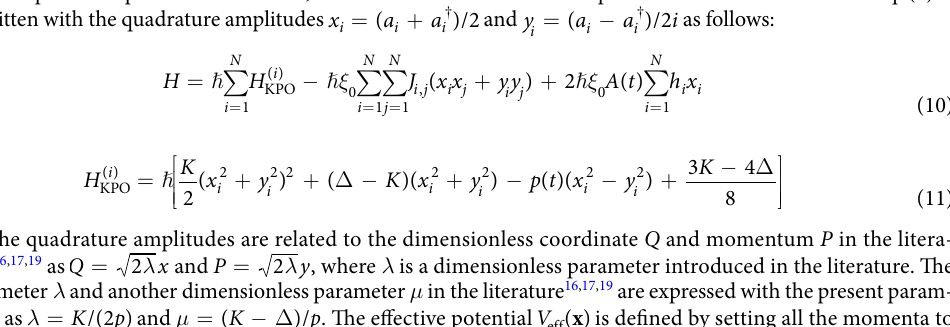
Figure 3. Simulation results of 1000 instances of the two-spin Ising problem. { } J from the interval ( − 1, 1). The time-dependent pump amplitude p ( t ) is set as in Fig. 2a. The other parameters are = and κ = . K 0 05 . ( a ) Histogram of the inverse effective temperature β determined by fitting to the set to p K 4 f final probability distribution. ( b ) Histogram of the corresponding Kullbak-Leibler (KL) divergence D minimized for the fitting in ( a ). The arrows indicate the results in Fig.